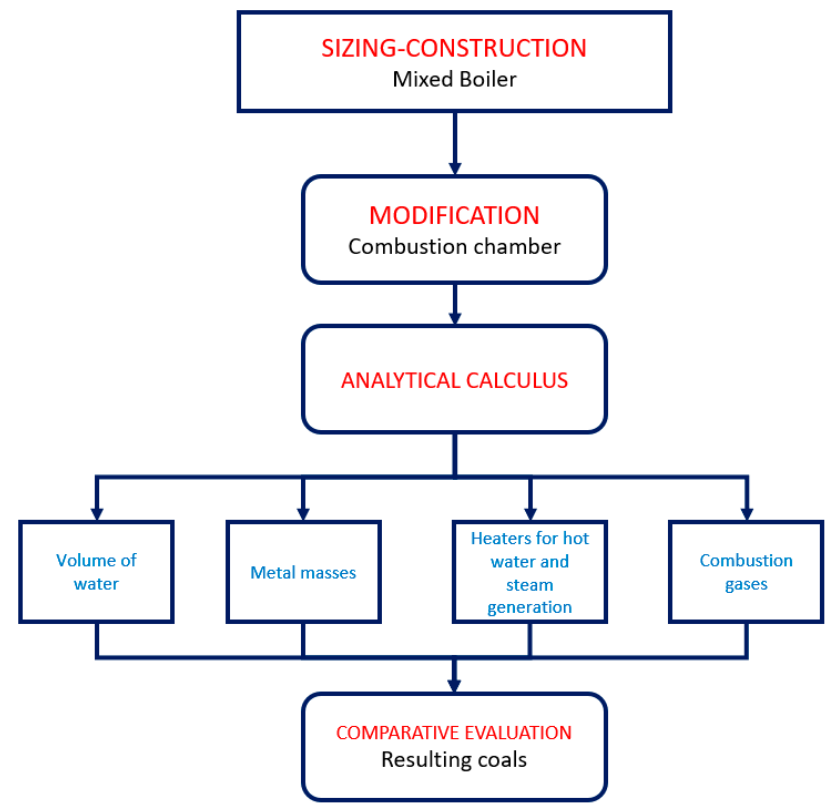
Figure 5. Processes considered.